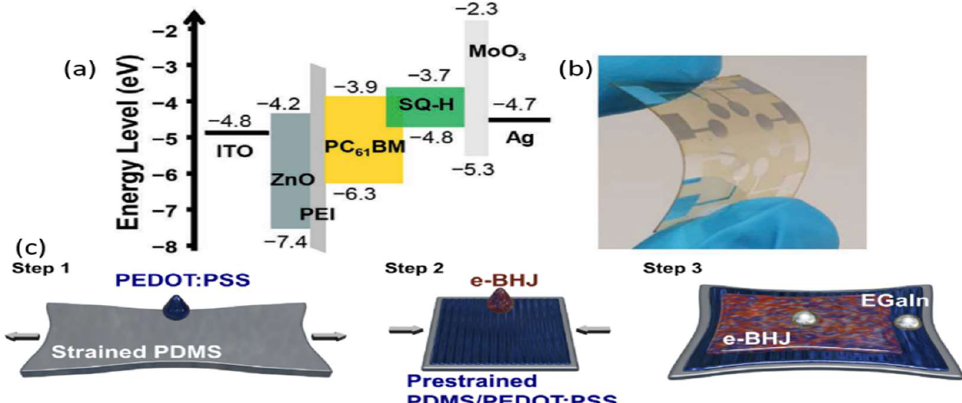
Figure 5. ( a ) Energy diagram of the SQ-H:PC61BM blend-based OPDs, ( b ) photographs of a flexible SQ-H-based OPD, reprinted with permission from [47] ©2021 Wiley, and ( c ) schematics of the fabrication process of the elastomeric OPD, reprinted with permission from [49] ©2021 American Association for the Advancement of Science.